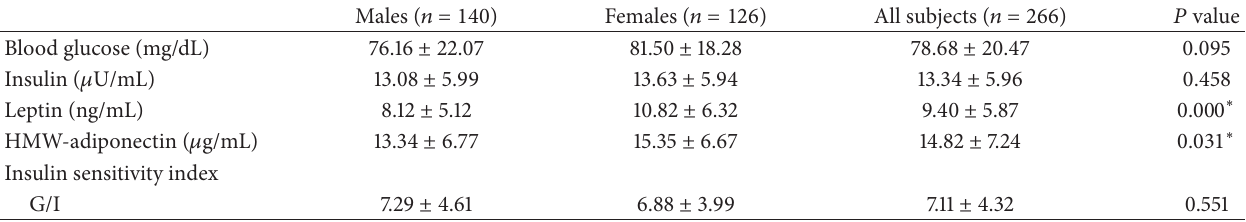
Table 2: Biochemical characteristics and estimates of insulin sensitivity in cord blood at